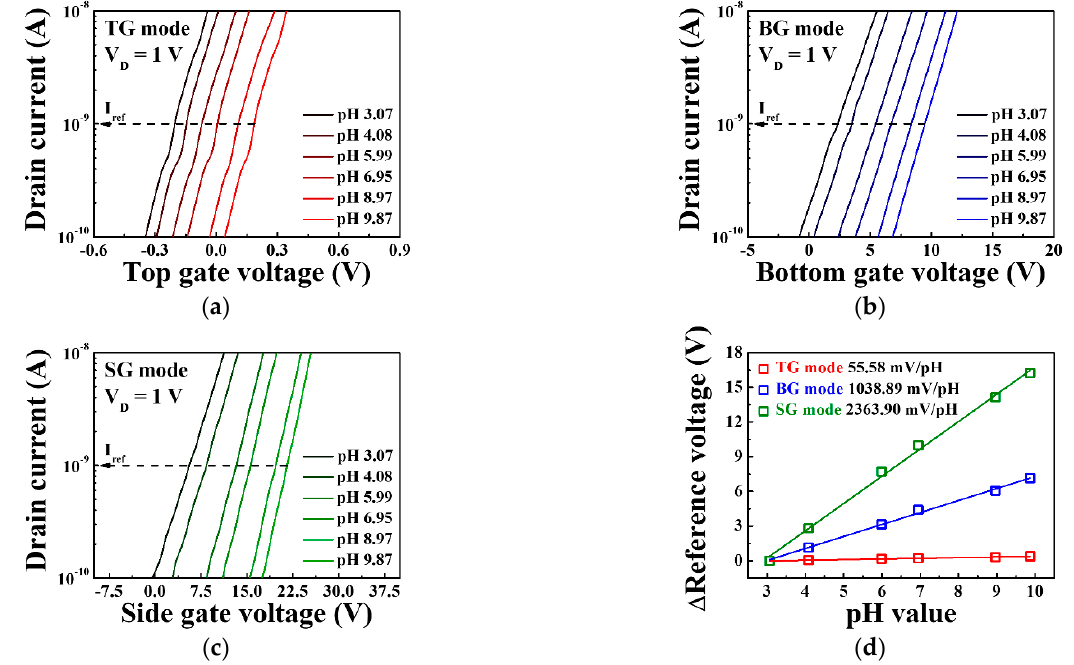
Figure 7. Transfer characteristic curves of the triple-gate a-IGZO TFT-based pH-ISFET sensor platform in ( a ) TG mode, ( b ) BG mode, and ( c ) SG mode. ( d ) Change in the reference voltage of the triple-gate a-IGZO TFT-based pH-ISFET sensor platform as a function of pH.